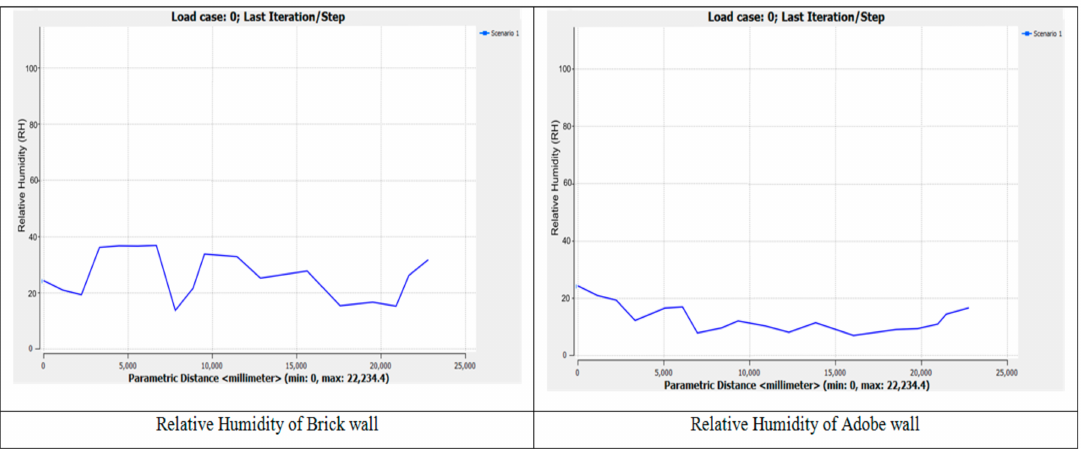
Figure 13. Calculated Relative Humidity through the Materials. CFD Autodesk 2016, 21 April